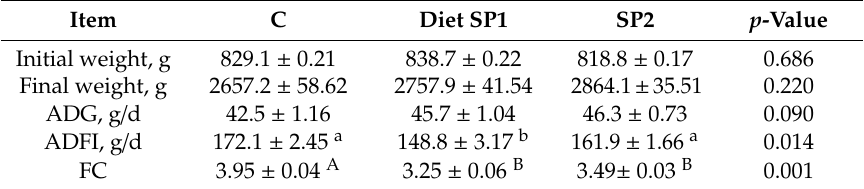
Table 3. Growth performances of rabbits fed the control diet (C) and diet supplemented with 3 g / kg (SP1) and 6 g / kg (SP2) of brown seaweed and plant polyphenols.